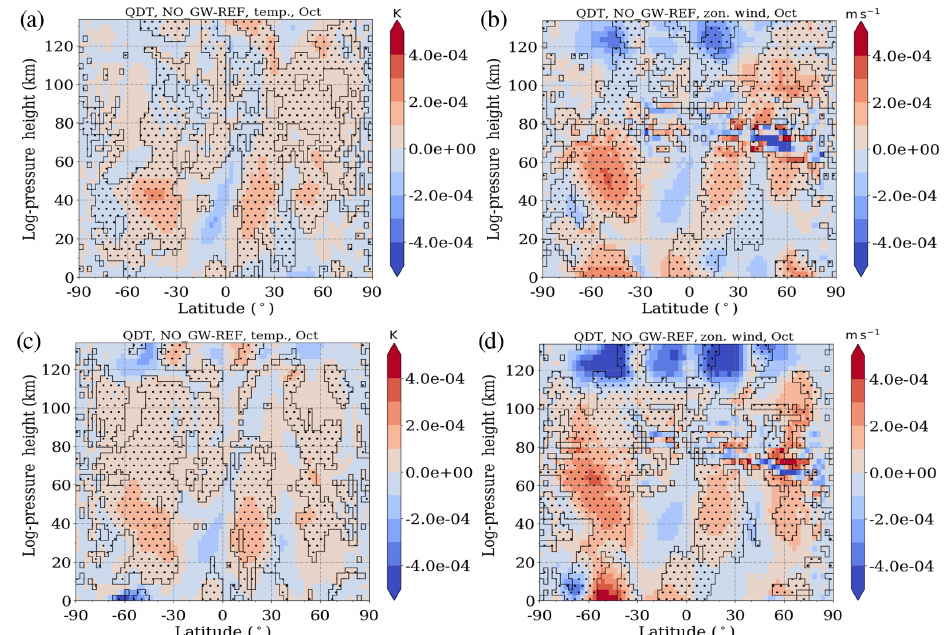
Figure 10. Difference of QDT amplitudes between the NO_GW and REF simulations, scaled by exp [− z( 2 H) − 1 ] . Red denotes larger NO_GW simulation amplitudes, and blue denote larger REF simulation amplitudes. Areas of destructive interference (120 ◦ ≤ (cid:49)(cid:56) ≤ 240 ◦ ) between the GW and SOL phases are hatched. Panels (a) and (c) show temperature, and panels (b) and (d) show zonal wind for (a, b) February and (c, d) October